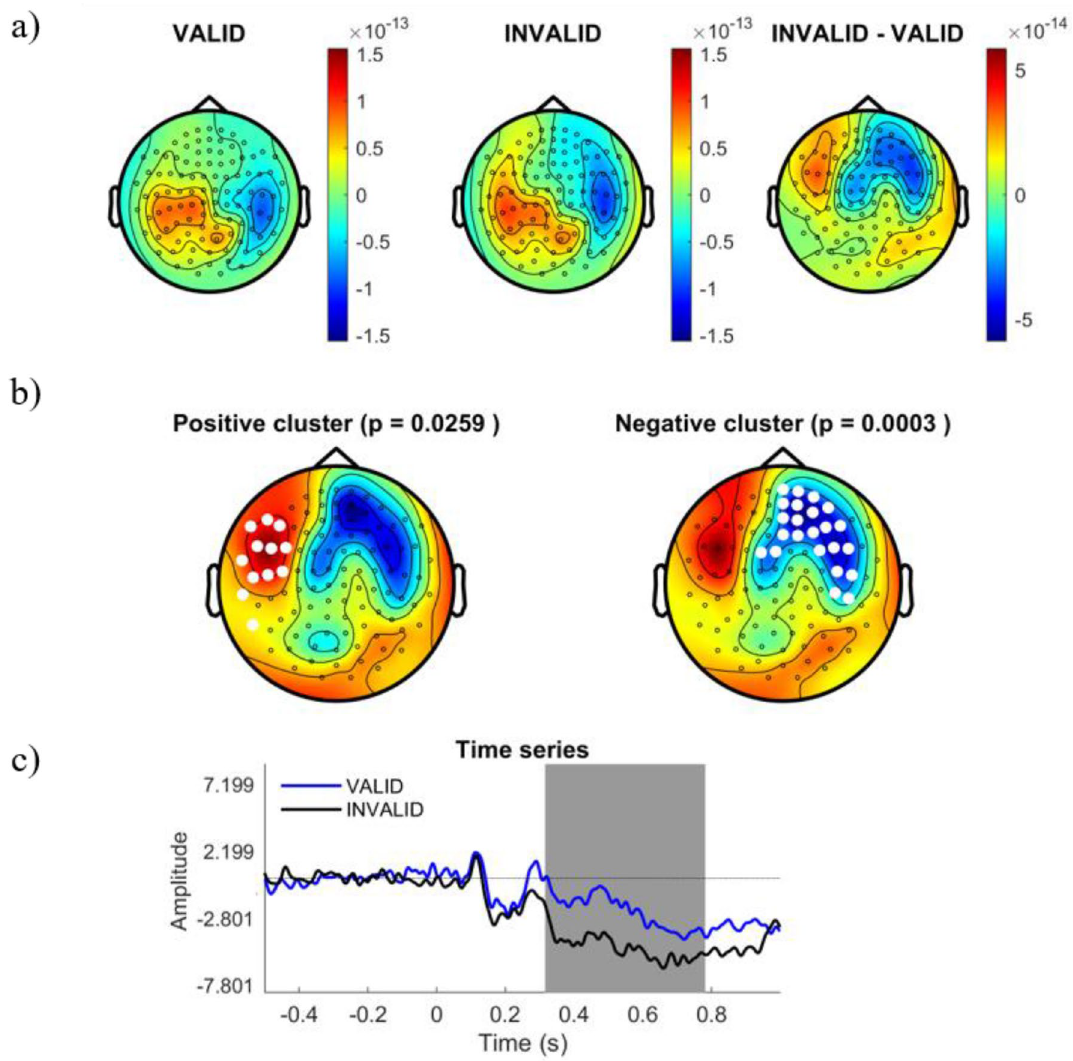
Figure 3. Represents the distribution of cortical activity from 310 to 780 ms. ( a ) Shows topographical maps of amplitudes for each condition (left and central map) and their arithmetic subtraction (right map). ( b ) Represents statistical differences (T values) between conditions. Left, positive cluster, and right, negative cluster. White dots represent sensors that showed significant differences during time-window. ( c ) Shows the whole time- series for both conditions (blue = VALID; black = INVALID). Grey mask represents time-slice of samples with significant